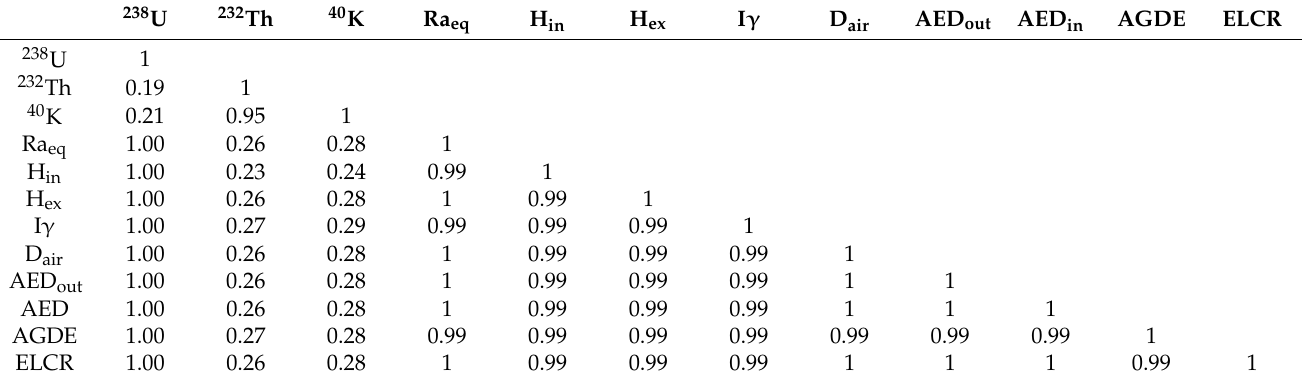
Table 7. The concentrations of radionuclides 238 U, 232 Th, 40 K and the radiological hazard indices. Ra eq H in H ex Iγ D air AED out AED in AGDE ELCR